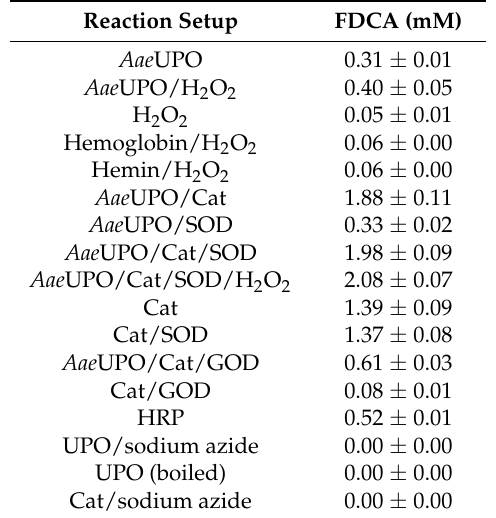
Table 2. FDCA formation from FFCA (2.5 mM) in the presence of different enzymes, enzyme cocktails and effectors. Reactions were performed in phosphate buffer (50 mM, pH 7.25) over 48 h. Concentrations given are mean values of three measurements with standard deviation.